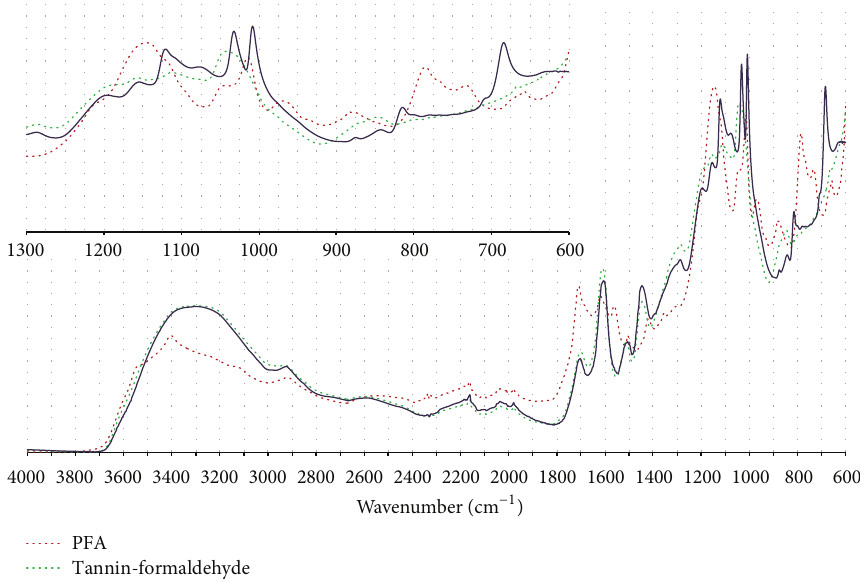
Figure 1: ATR FT-IR spectra of polyfurfuryl alcohol (red dot) tannin-formaldehyde polymer (green dots) and classic tannin based rigid foam (dark blue).